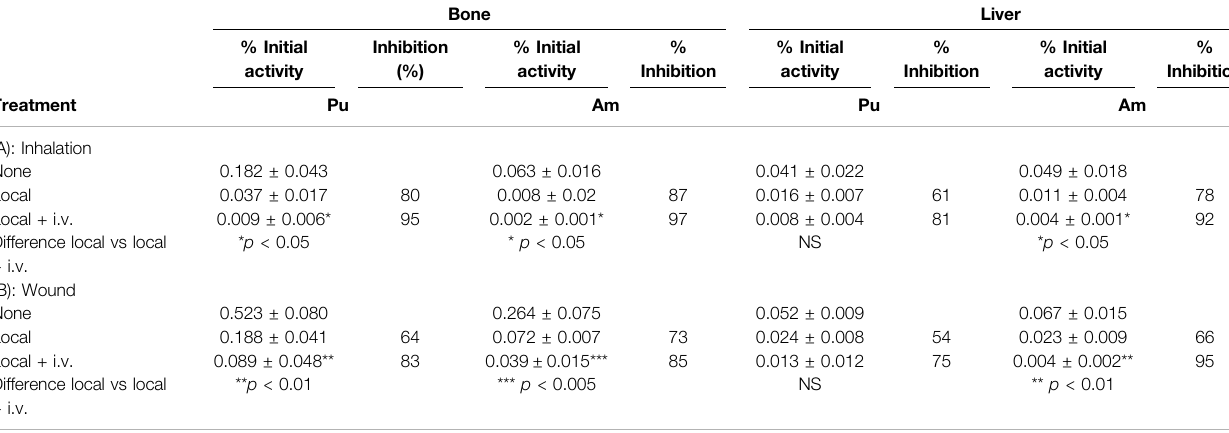
TABLE 3 | Comparative ef fi cacy of two different DTPA treatment protocols on tissue Pu and Am levels.